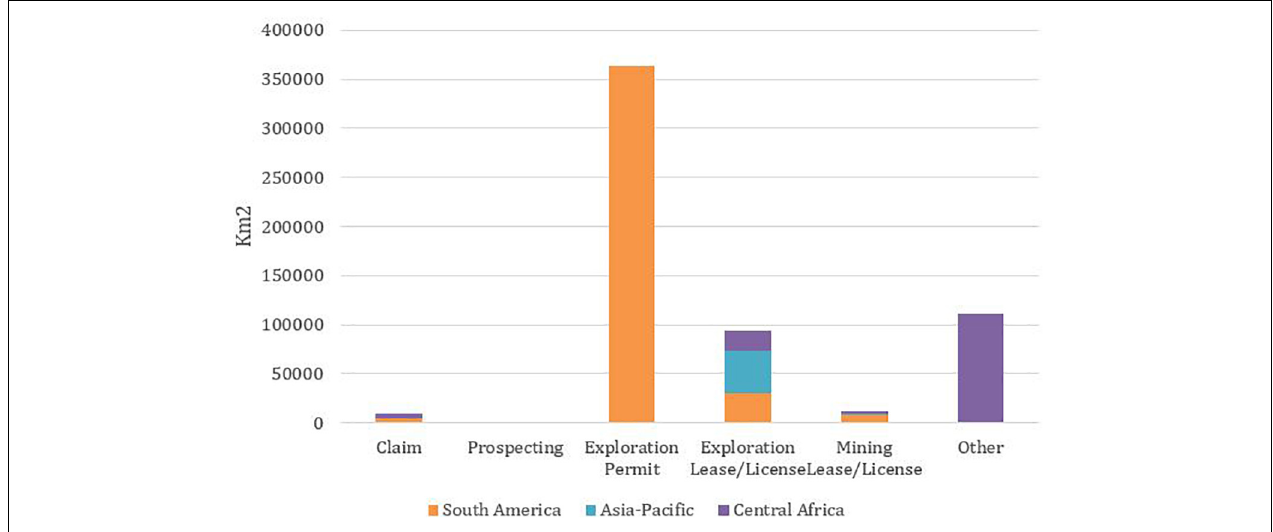
FIGURE 6 | Stage of operations for mining leases where mining claims overlap